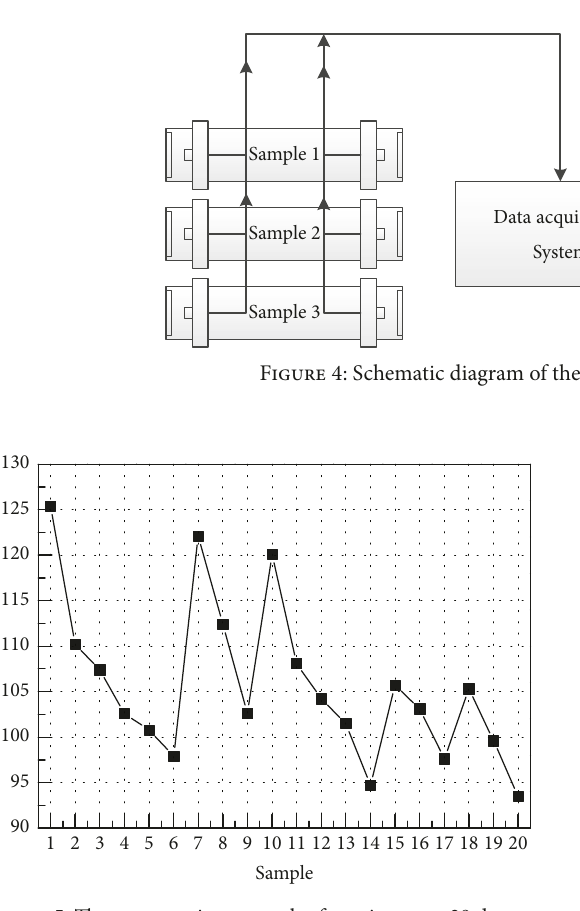
Figure 5: The compressive strength of specimens at 28 days. Figure 6: The flexural strength of specimens at 28